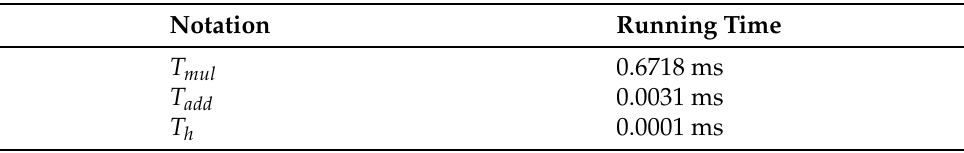
Table 2. Notation with its Costs of Running Time.